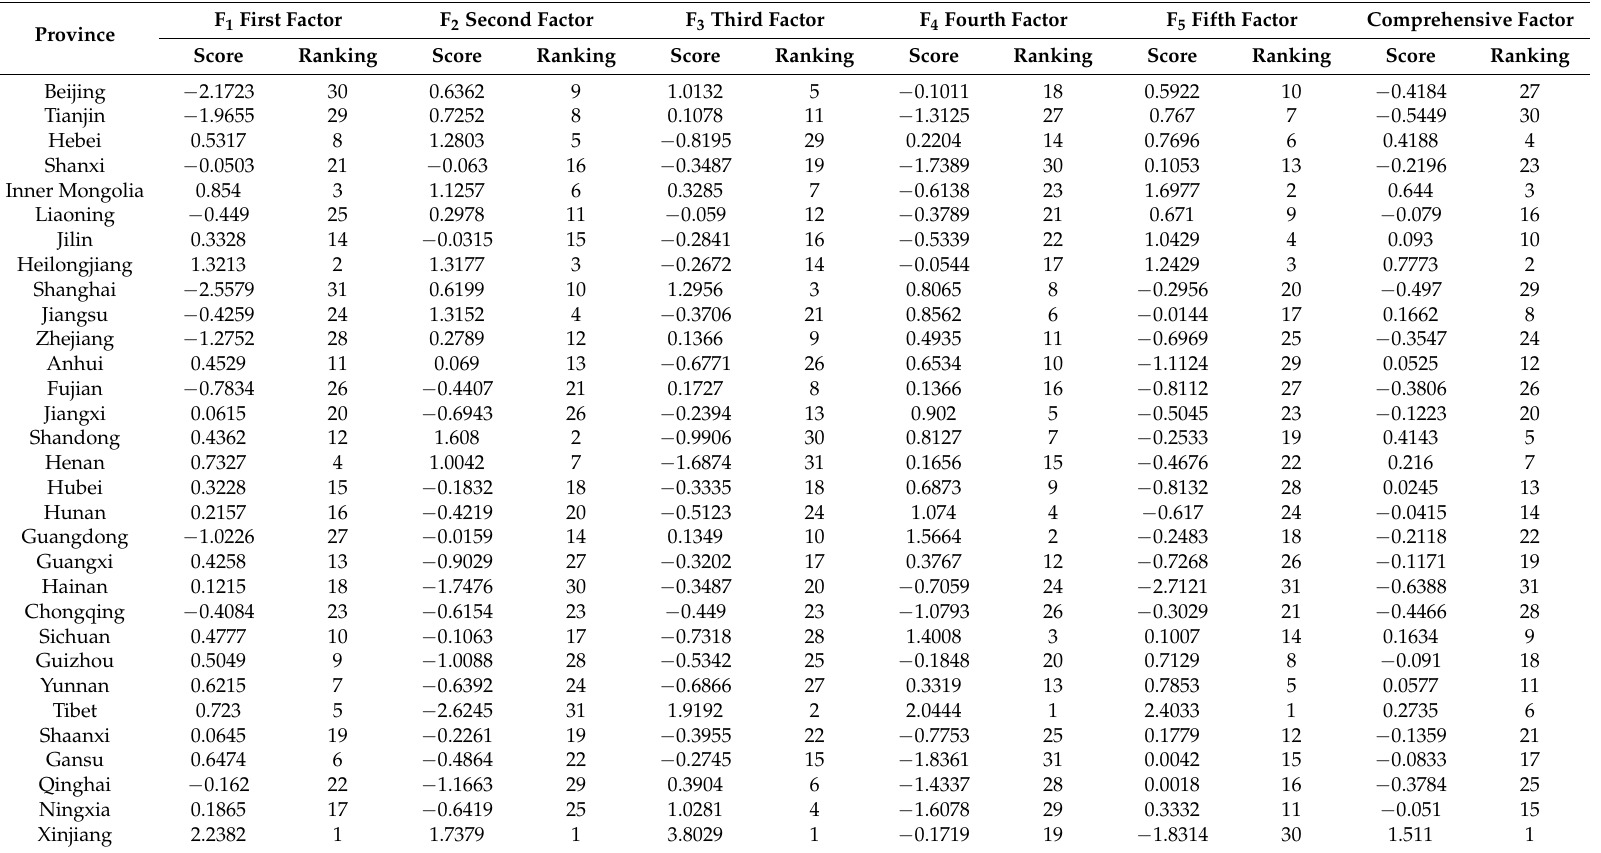
Table 4. Factor scores, comprehensive evaluation scores and ranking of 31 provinces in